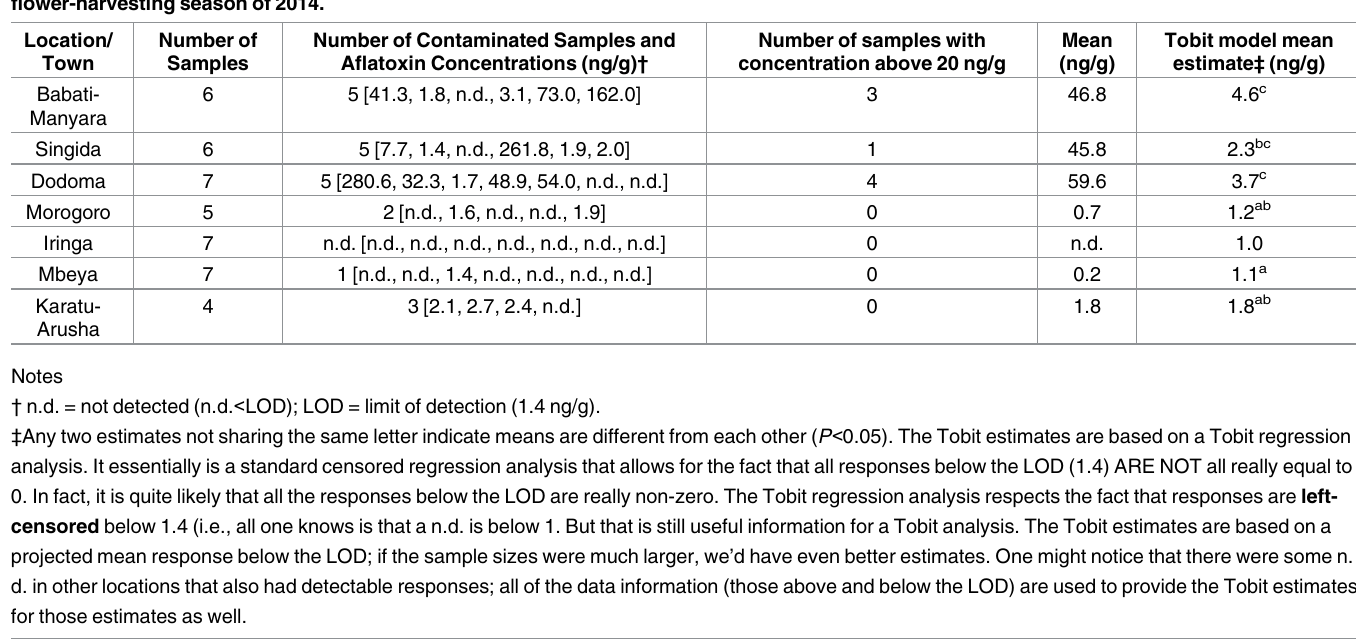
(1.6–1.9), Mbeya (0–14) and Karatu-Arusha (2.1–2.7 ng/g). Aflatoxins were not detected in samples collected from Iringa. Of seven samples from Dodoma, five were contaminated (71%) and one of the five samples had highest concentration of 280.6 ng/g. Of six samples from Sin- gida, five were contaminated (83%) and one sample contained a maximum concentration of 261.8 ng/g, while 83% of the six samples from Babati were contaminated and the maximum concentration was 162 ng/g. Of seven samples from Mbeya, only one sample (14%) was con- taminated (1.4 ng/g). Karatu had only four samples of which three were contaminated and the maximum concentration was 2.7 ng/g.